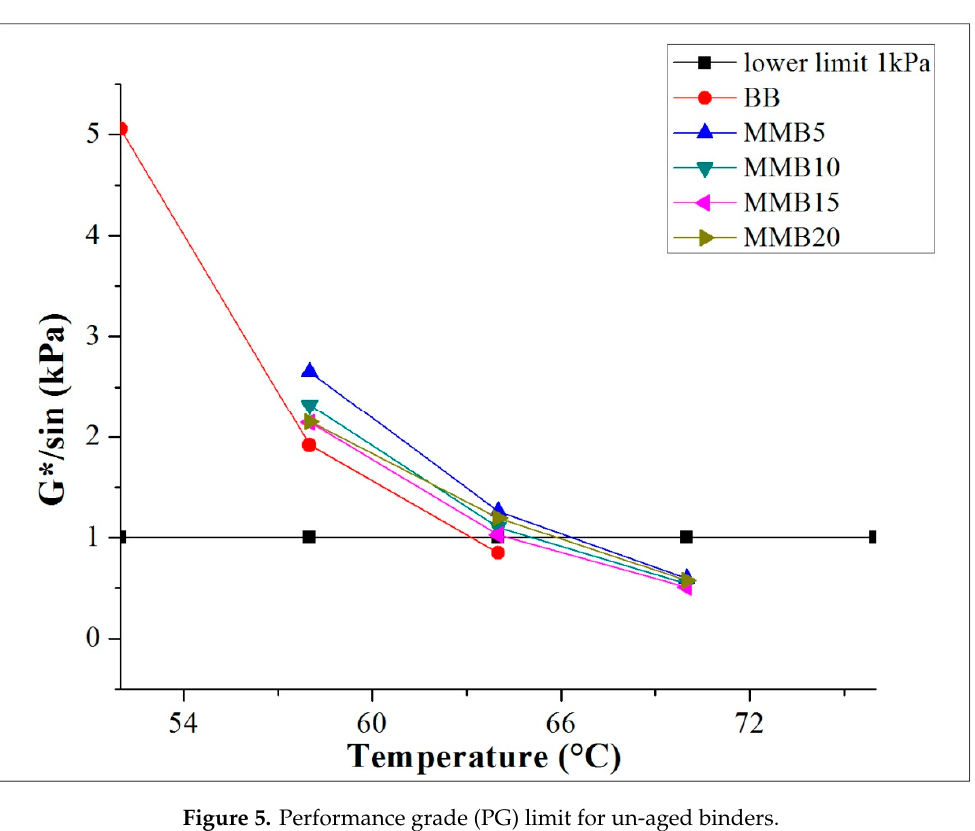
Figure 5. Performance grade (PG) limit for un-aged binders.